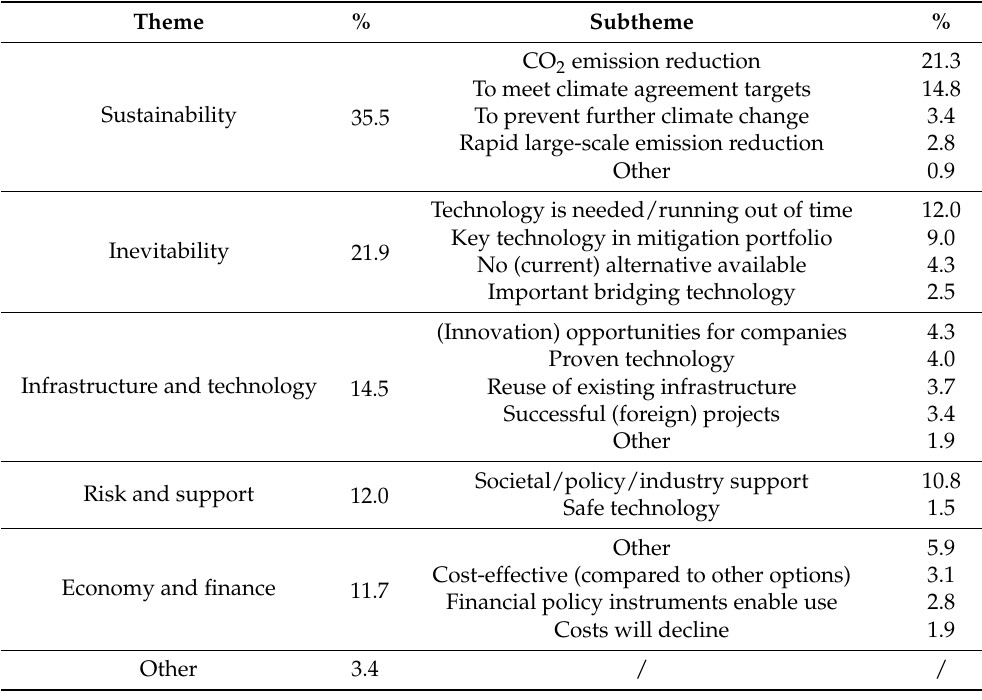
Table 2. Arguments in favor of CCS: (sub)themes and the proportion of articles that use at least one argument within each (sub)theme ( n = 324